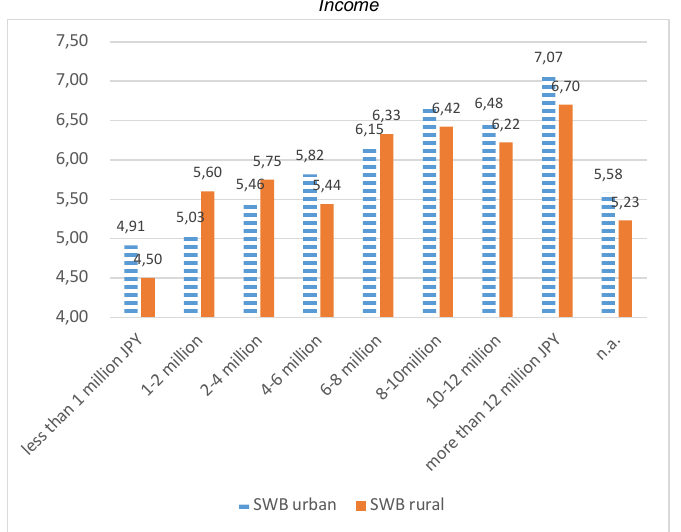
Figure 3. Distribution of Average SWB score in each income